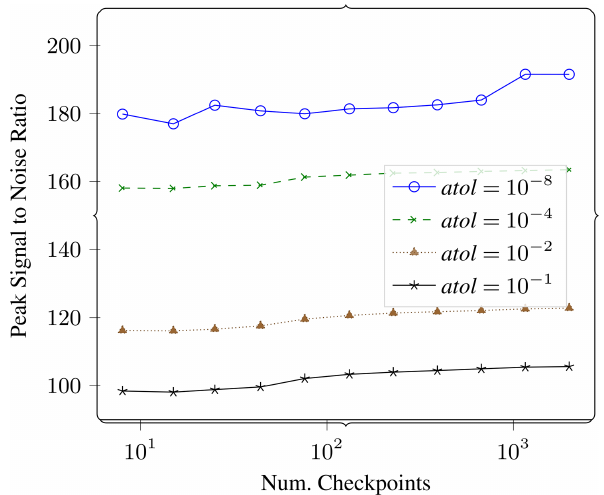
Figure 12. Gradient error. In this plot we measure the effect of vary- ing number of checkpoints on the error in the gradient. We report PSNR of lossy vs. reference gradient as a function of number of checkpoints for four different compression settings.